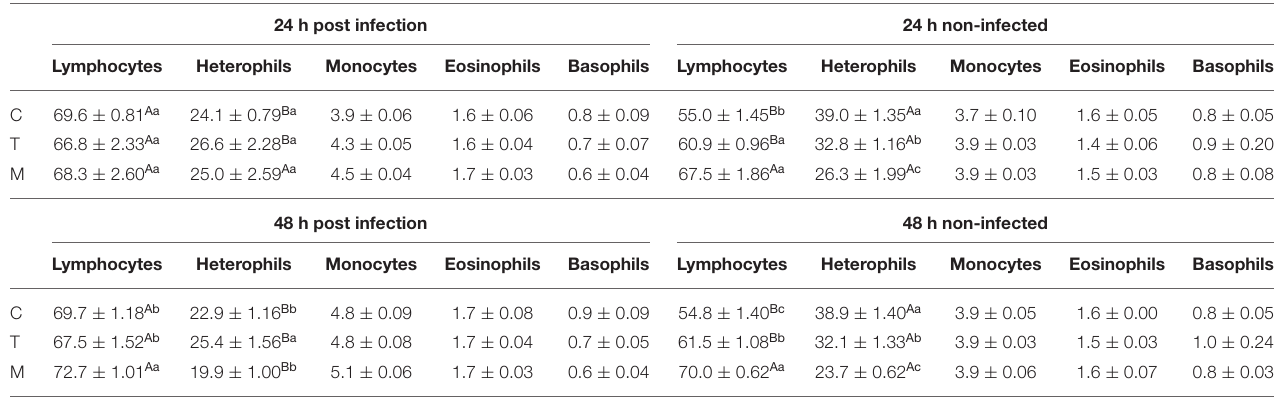
TABLE 5 | Differential leukocytic counts (%) of mono-sex Nile tilapia supplied with Moringa oleifera leaf including diet. 24 h post infection 24 h non-infected Lymphocytes Heterophils Monocytes Basophils Monocytes